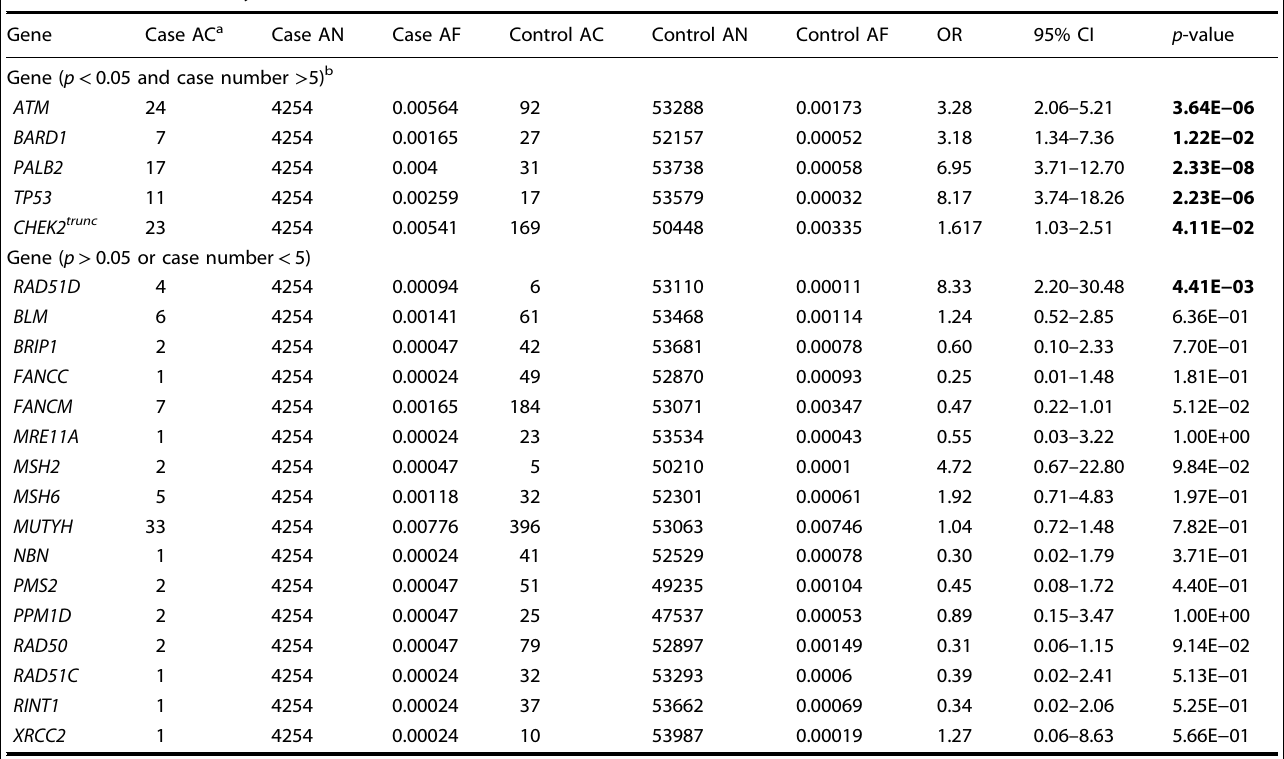
Table 3. Case – control